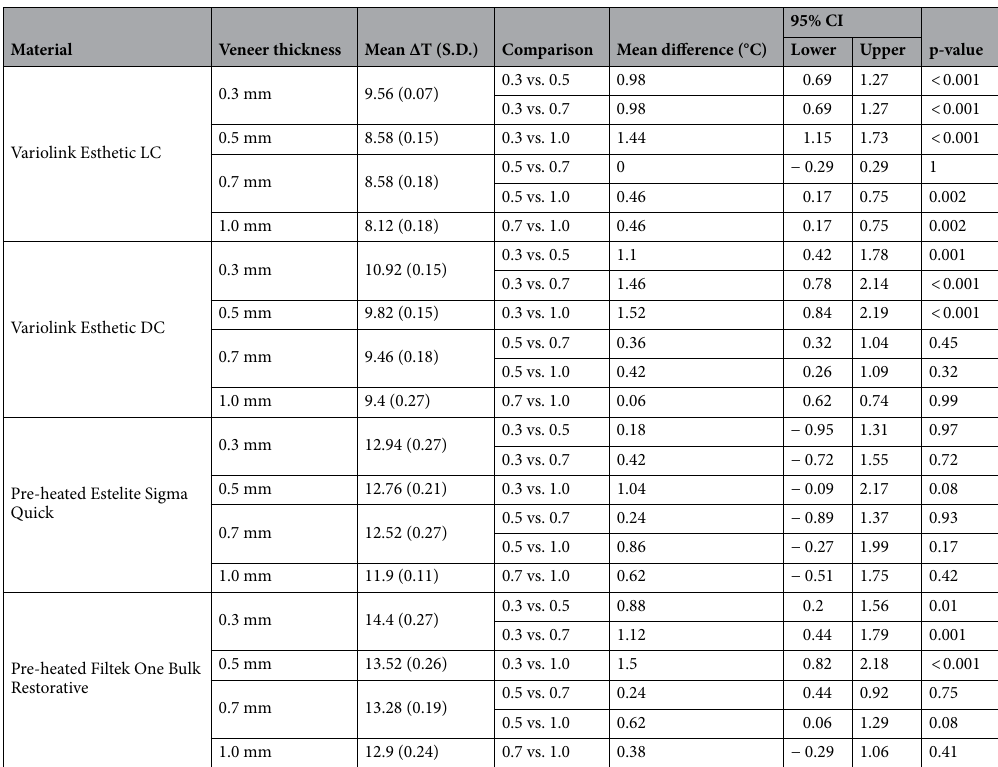
Table 3. Comparison of intrapulpal temperature change during polymerization through different thickness of ceramic veneers. One-way analysis of variance (ANOVA) and Tukey’s post hoc adjustment. S.D. standard deviation, ΔT temperature change, CI confidence interval, LC light-cure, DC dual-cure.